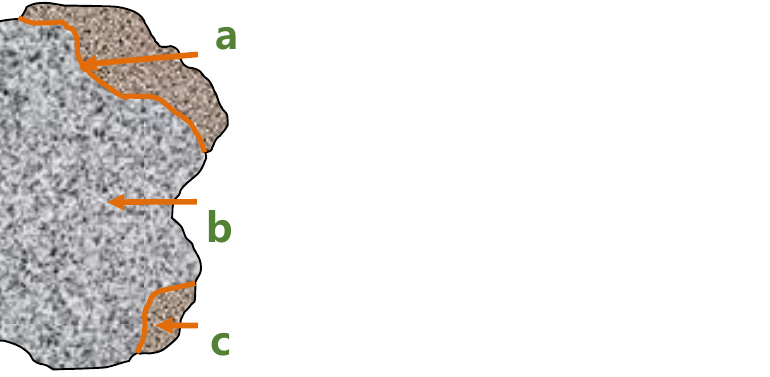
Figure 4. Appearance diagram of the recycled coarse aggregate: ( a ) The old interface; ( b ) Original natural aggregate; ( c ) Waste mortar.